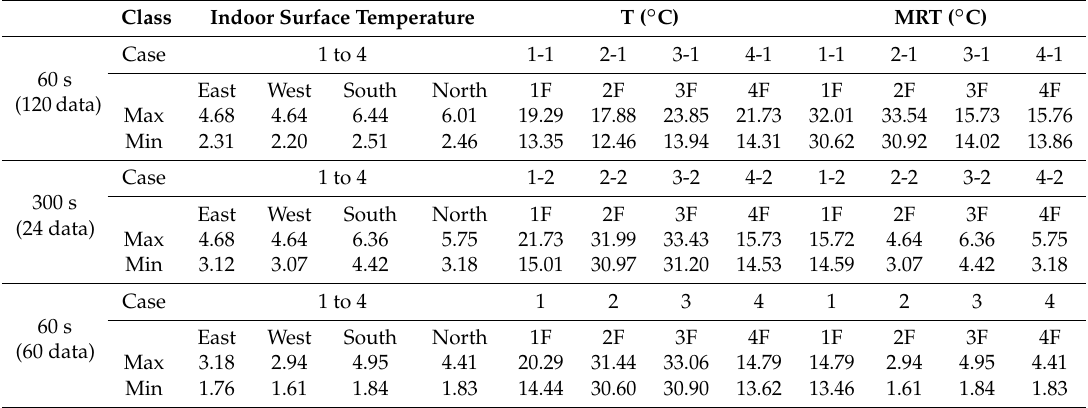
Table 4. Maximum and minimum range of dataset for T and MRT prediction models.